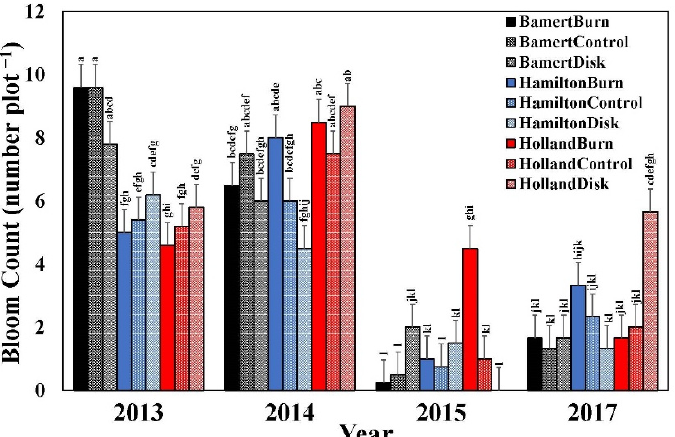
Figure 2. Total bloom count by pollinator mixture and disturbance regime measured at the Natural Resources Conservation Service Plant Materials Center in Booneville, AR in 2013, 2014, 2015, and 2017. Means with the same letter are not different at p < 0.05. Each error bar represents one standard